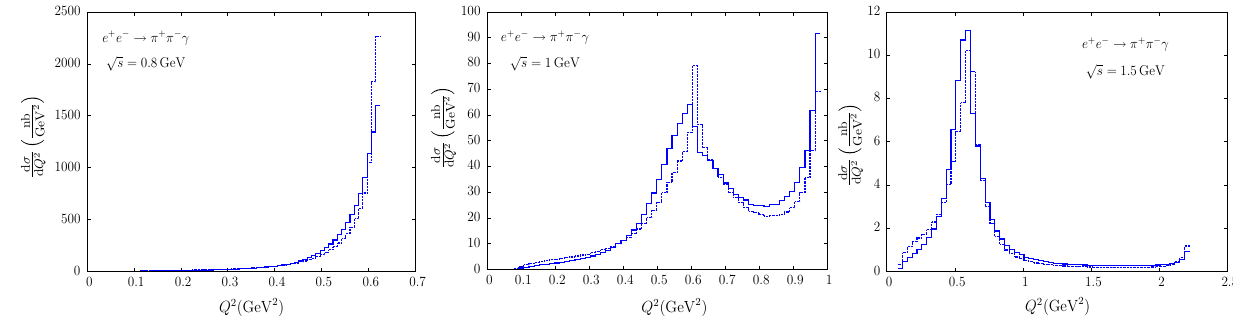
Fig. 12 The differential cross sections of (4) as functions of invariant mass of the π + π − -pair computed in a model with the charged pion form factor ( solid lines ) and in the HLS model with fixed couplings ( dotted lines